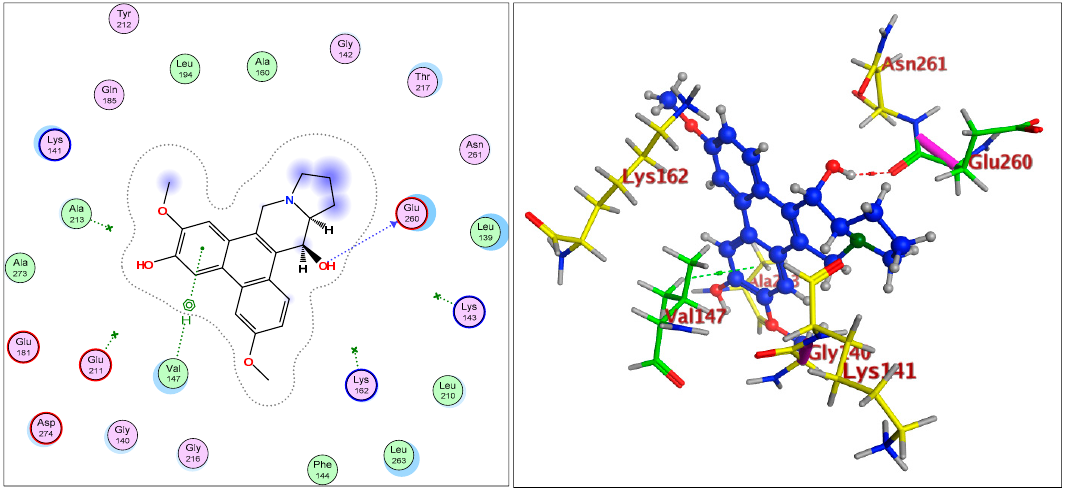
Figure 3. Overlay of compound ( 6 ) bound to the active site of ATP-binding pocket of Aurora-A. The participations of certain amino acids at the binding domains of the Aurora kinases were demonstrated. Compound ( 3 ) with pose 15, and energy binding requirements/stabilization energy at − 6.79 kcal/mol; compound ( 5 ) with pose 21, and energy requirements at − 7.45 kcal/mol; and compound ( 6 ) with pose 27, and energy requirements at − 7.24 kcal mol (compared with the score binding energy of ADP; the co- crystalline ligand of Aurora-A at − 8.32 kcal/mol) suggested their plausible geometric orientations, binding mode, and energy requirements for the better anticancer activity elicitation based on the molecular docking details as outlined (Figures 1–6, Table 2). The Aurora-A and B in vitro activity, IC 50 levels, for compounds ( 3 ), ( 5 ), and ( 6 ) were found to be 3.6 ± 0.93 μ M and 4.1 ± 1.08 (compound ( 3 ), Aurora-A and B, respectively); 1.3 ± 0.58 μ M and 0.6 ± 0.72 (compound ( 5 ), Aurora-A and B, respectively); and 6.5 ± 0.76 μ M and 2.6 ± 0.86 (compound ( 6 ), Aurora-A and B, respectively) (Table 3), again confirmed the levels and outreach of the active compounds.